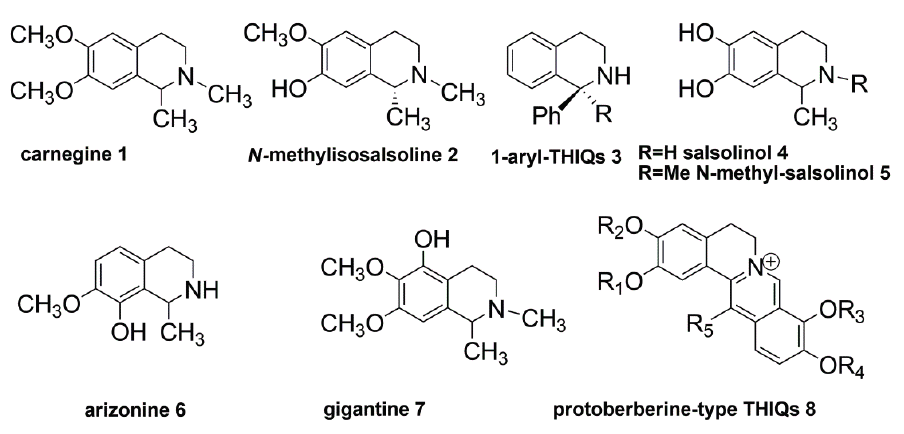
Figure 1. Structure of some natural and synthetic 1,2,3,4-tetrahydroisoquinoline (THIQ)